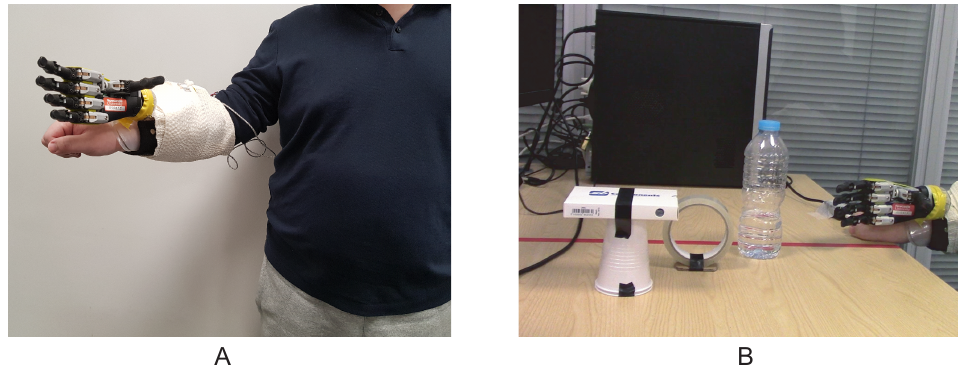
Figure 3. The pick-and-place experiment setup. ( A ) The participant wore the Robo-limb prosthetic hand on his right arm with a customised socket. The prosthetic hand was powered by the battery mounted on the socket and the Arduino system was connected to the computer so that the user could switch the controller during use through the user interface. ( B ) The participant was instructed to grasp and relocate three objects using the prosthetic